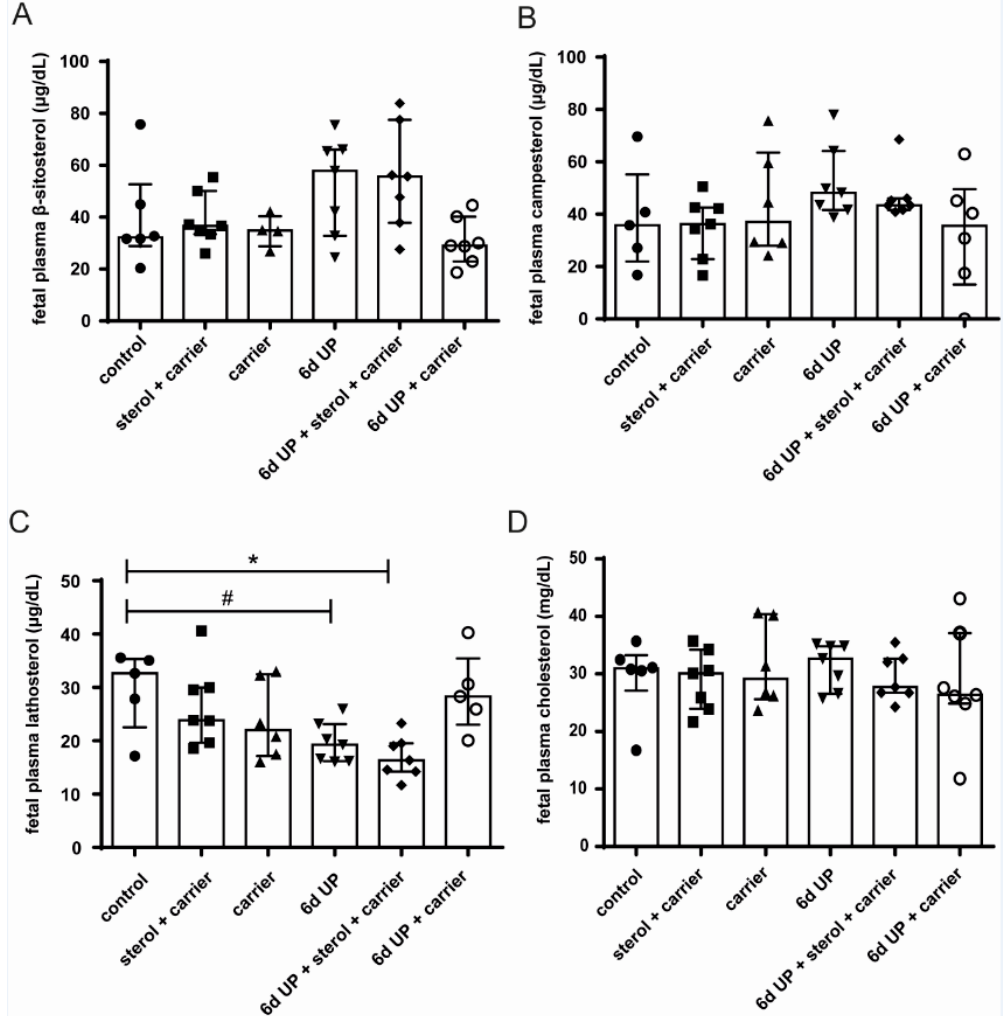
Figure 6. Circulatory β -sitosterol, campesterol, lathosterol (cholesterol precursor), and cholesterol levels in lambs of 133 d GA (preterm delivery). No significant differences were found for β -sitosterol ( A ) and campesterol ( B ) in all treatment groups. ( C ) UP exposure with and without plant sterol treatment reduced lathosterol plasma concentrations compared to controls. ( D ) Plasma cholesterol concentrations were not affected by UP exposure and/or plant sterol treatment. * p < 0.05; # 0.05 < p < 0.10. Abbreviations: GA, gestational age; UP, U. parvum .